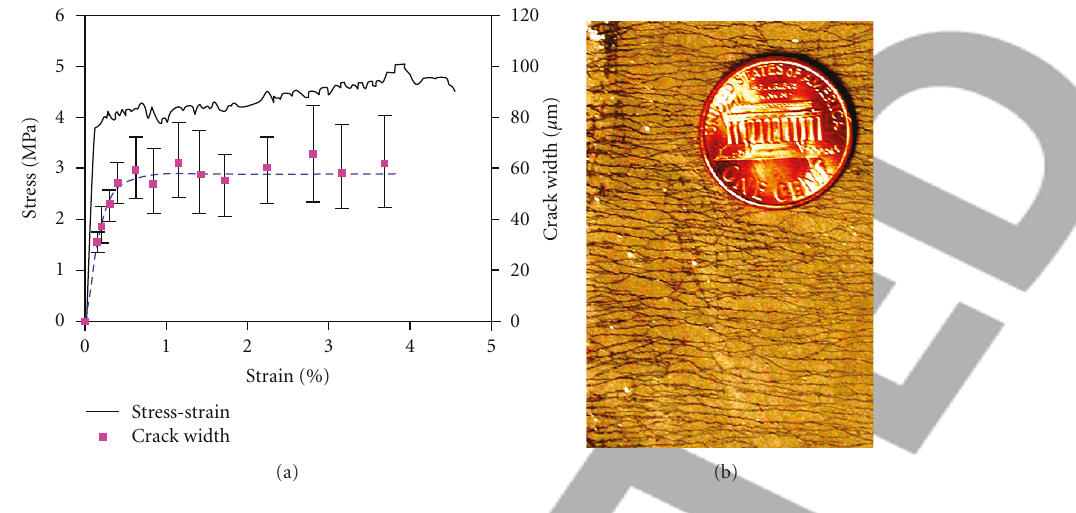
Figure 1: Typical stress-strain-crack width relationship and saturated crack pattern of PVA-ECC.